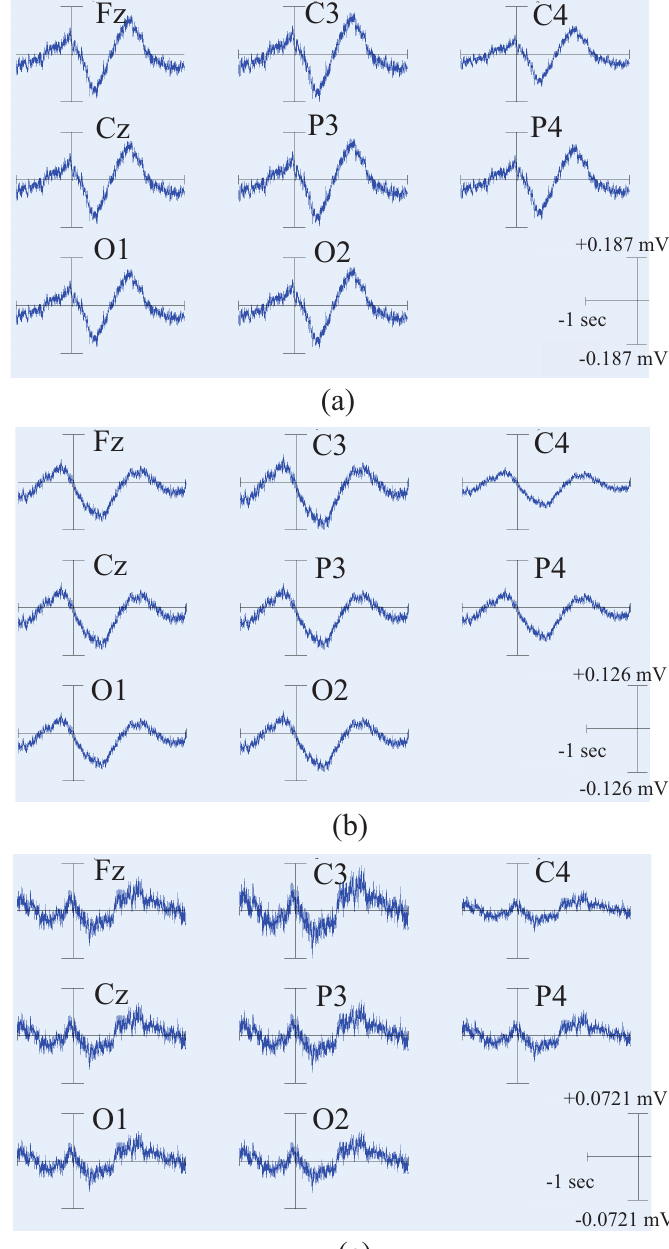
Figure 10. Average results of the feature component distributed in each channel of subject A ( a ), B ( b ) and C ( c ). Each subpanel shows the result of each measurement channel. Here, the horizontal axis is time and the vertical axis is the amplitude of EEG